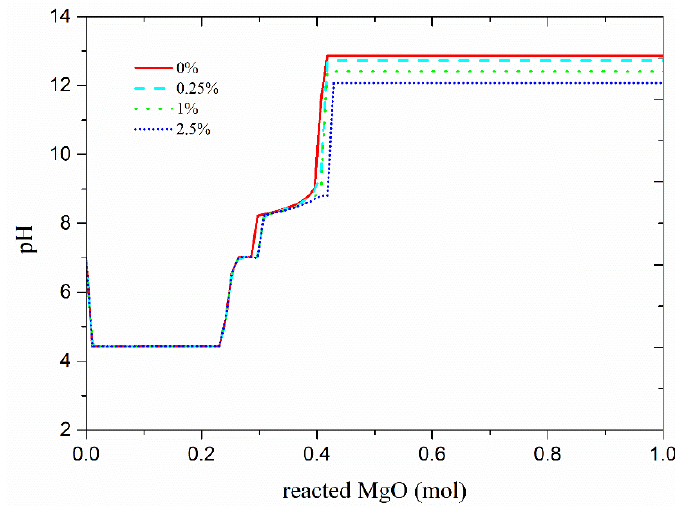
Figure 4. Comparison of pH in MKPC pastes with different amounts of boric acid.